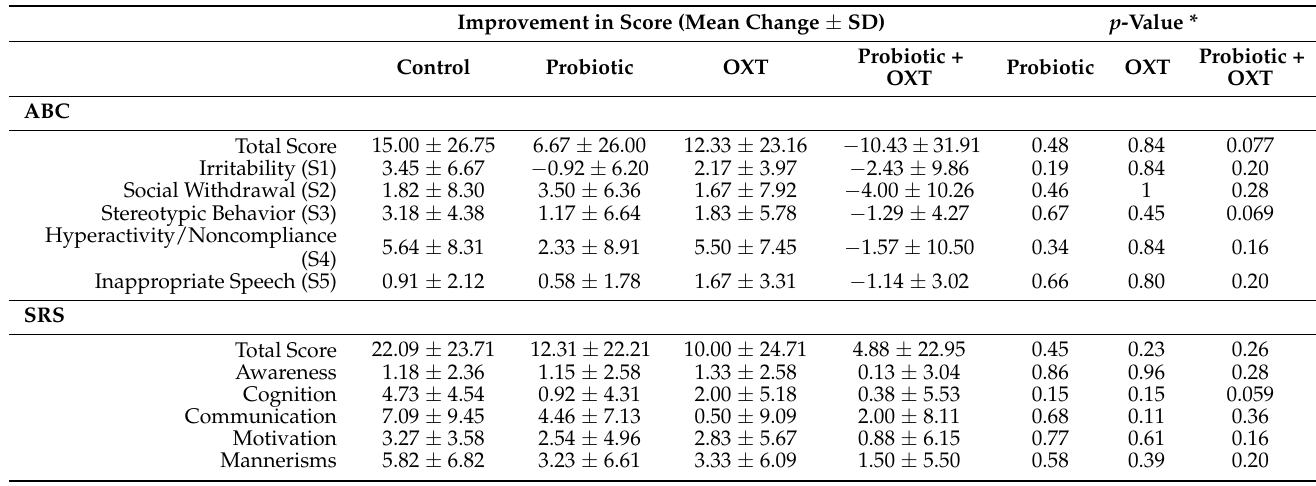
Table 2. Summary of improvement in socio-behavioral measures. Data are presented as mean change ±